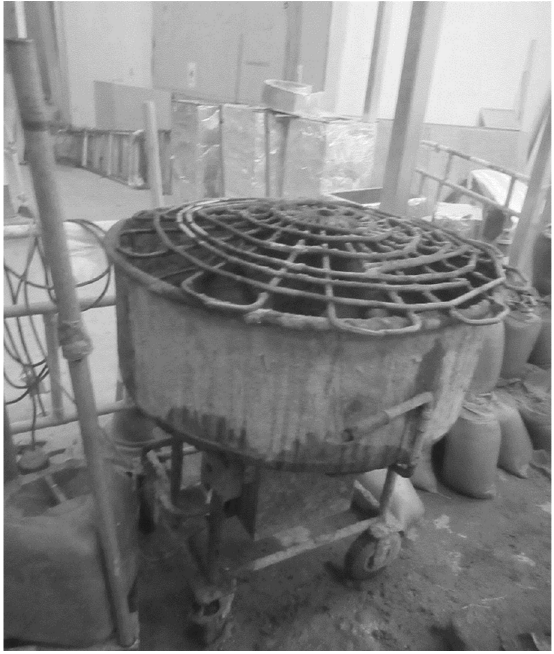
Figure 7. Wet cement sand mixing for building a brick wall at a renovation site .